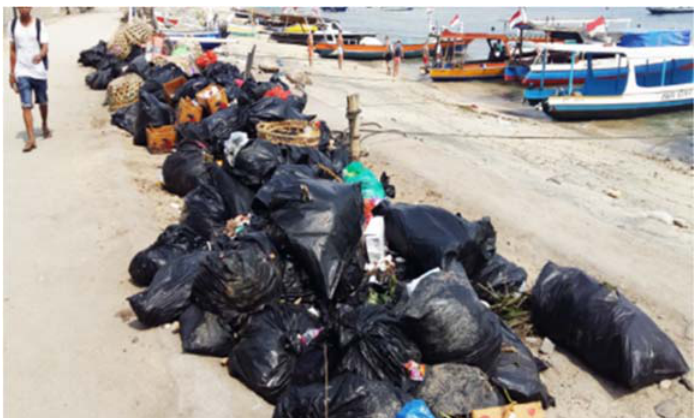
Figure 3. Mounds of waste by settlement and tourism accommodation at Gili Air’s coast, one of the Gili Matra Islands [29].